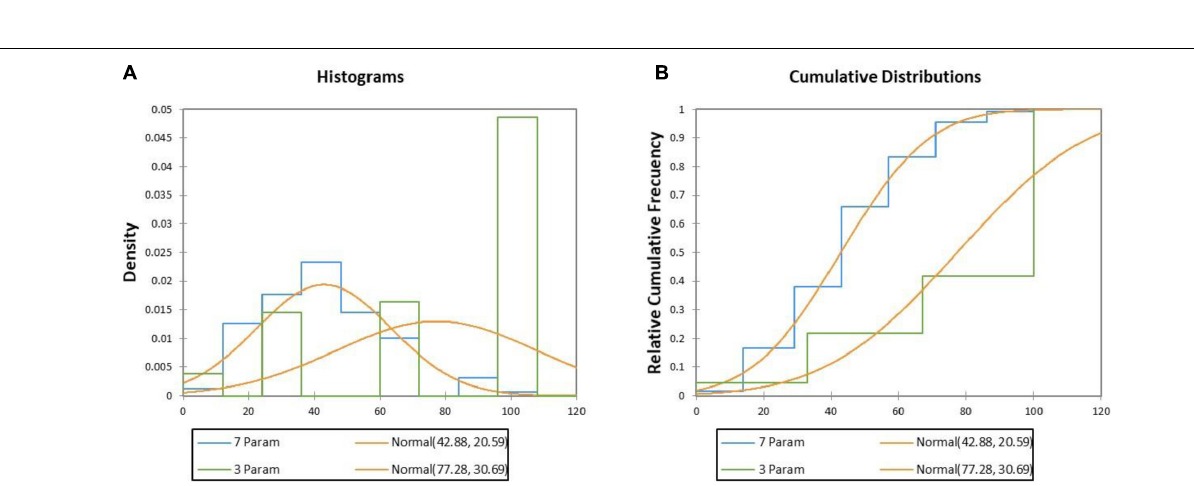
FIGURE 10 | Measured (vertical axis) and calculated (horizontal axis) longshore sand transport rates for a typical stretch in the Spanish Mediterranean coast (black line corresponding to the Tarragona province) and for a sediment starved coastal sector in the Ebro delta (red line corresponding to the Cap Tortosa area). The dashed areas indicate profiles where the calculated transport exceeded by almost an order of magnitude the measured one, highlighting the fact that transport formulations provide a potential transport capacity rather than the actually verified transport.